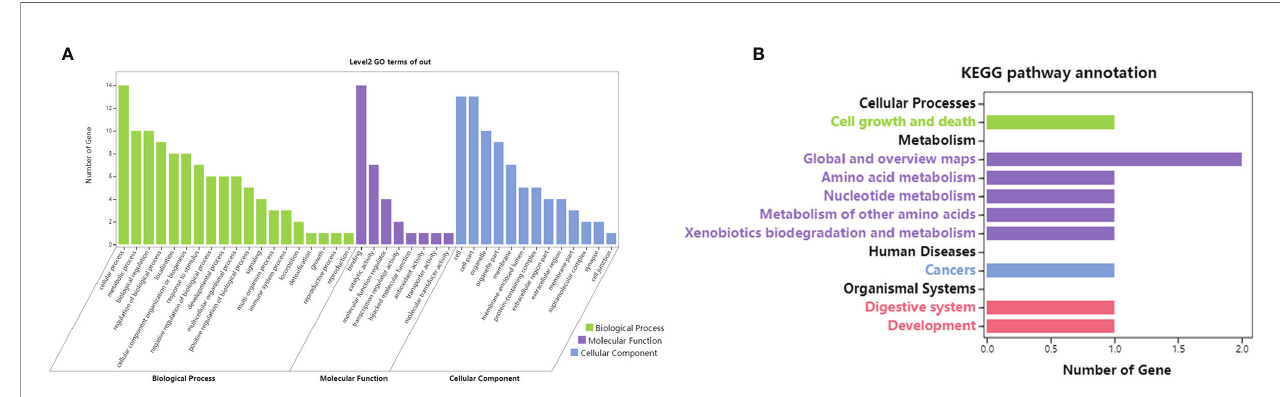
FIGURE 9 | GO and KEGG enrichment of 15 gene signatures. [ (A) GO enrichment of 15 gene signatures; (B) KEGG enrichment of 15